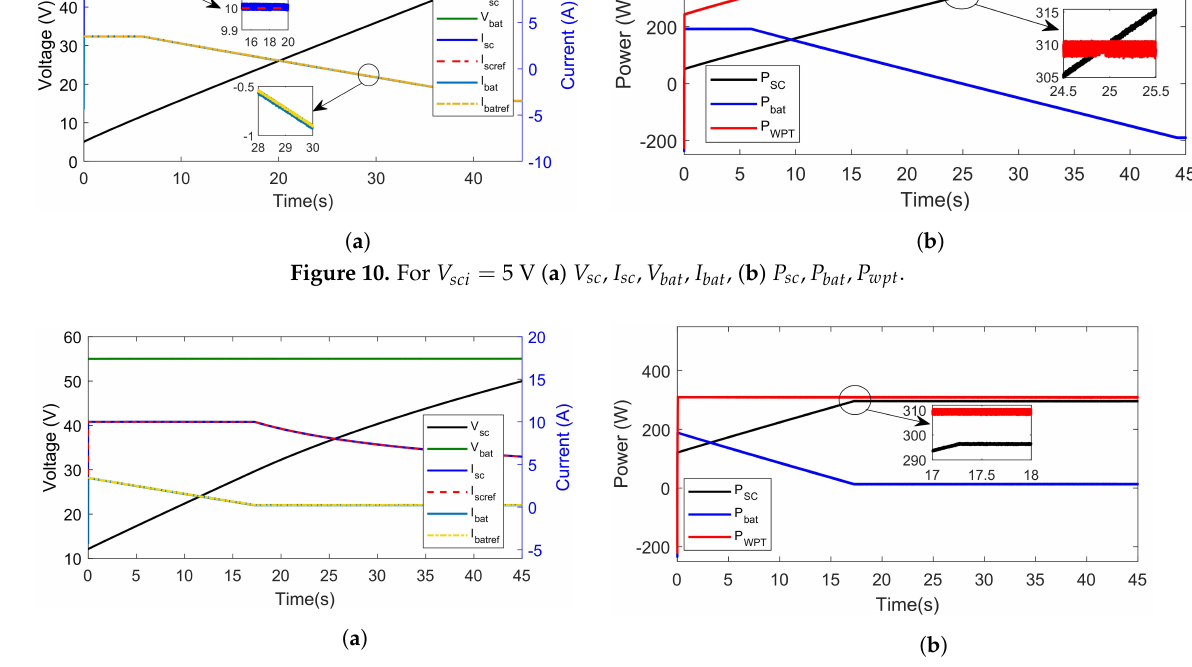
Figure 11. For V sci = 12 V ( a ) V sc , I sc , V bat , I bat , ( b ) P sc , P bat , P wpt . When V sci was increased to 22 V, using Equation (41), P t was calculated to be 224 W. Following the power allocation strategy, only the constant power mode was utilized to charge the SC. The remaining power from the WPT was used to charge the battery to ensure the optimal power generation from the WPT system. Figure 12a,b depicts this charging process.